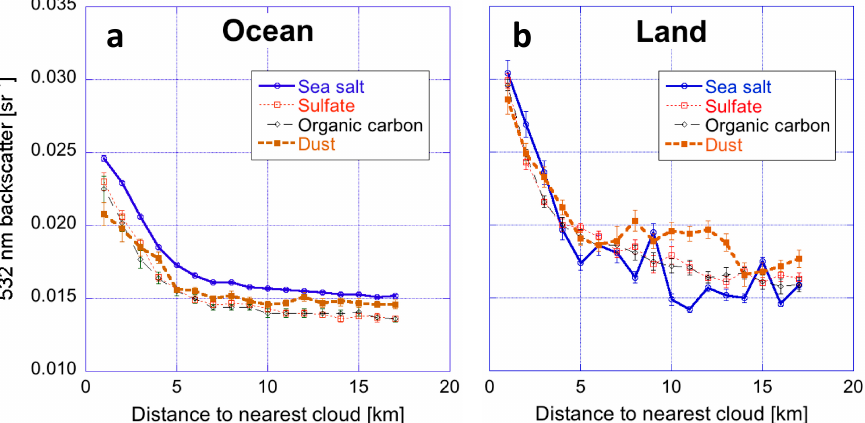
Figure 6. Mean vertically integrated lidar backscatter for cases dominated by certain aerosol types. Black carbon is not included because it never dominated the aerosol population in our dataset. ( a ) Data over ocean (Data used are available at Table S8); ( b ) Data over land (Data used are available at Table S9). Fraction of used CALIOP columns (in %) assigned to each aerosol type in plotting Figure 6 is available at Table S12.